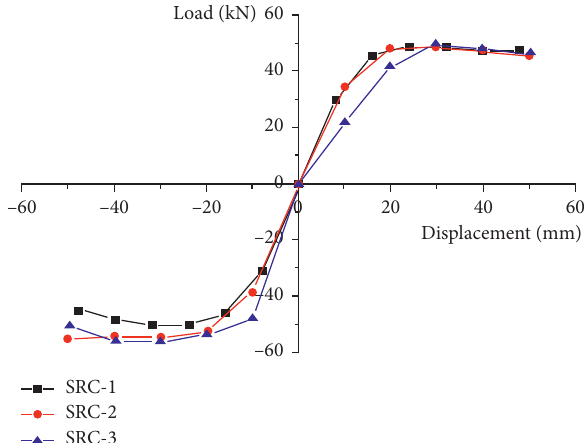
Figure 13: Envelope curves under varying axial compression